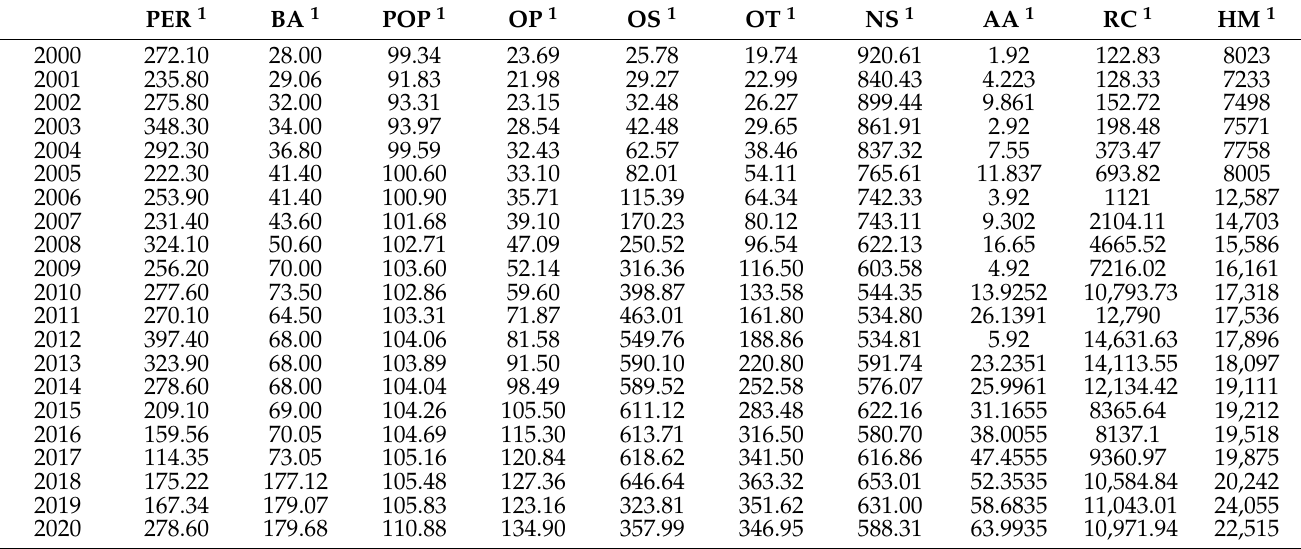
Table A1. Statistics of the Xilin Gol League from 2000 to